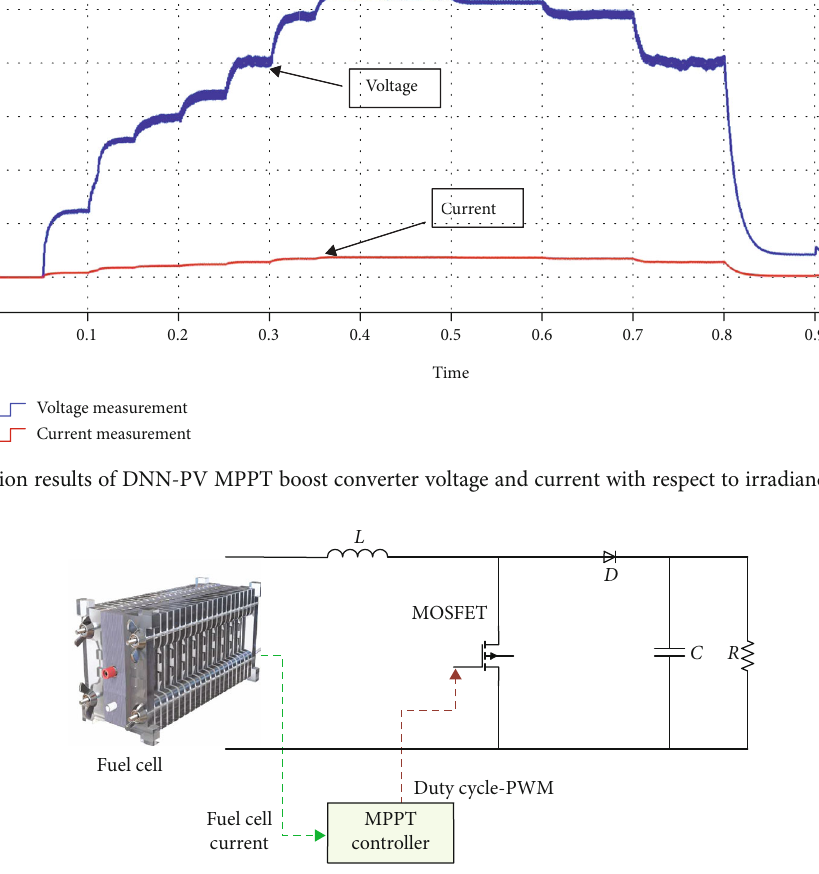
Figure 11: Proposed DNN-based optimum fuel fl ow algorithm for the fuel cell power system.